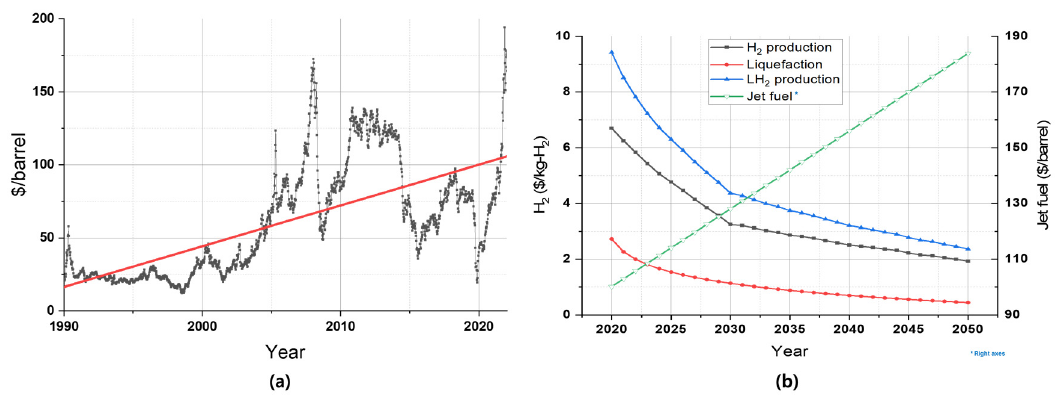
Figure 5. ( a ) Jet fuel price trend [45] and ( b ) forecast of Jet A fuel and LH 2 fuel price [46].